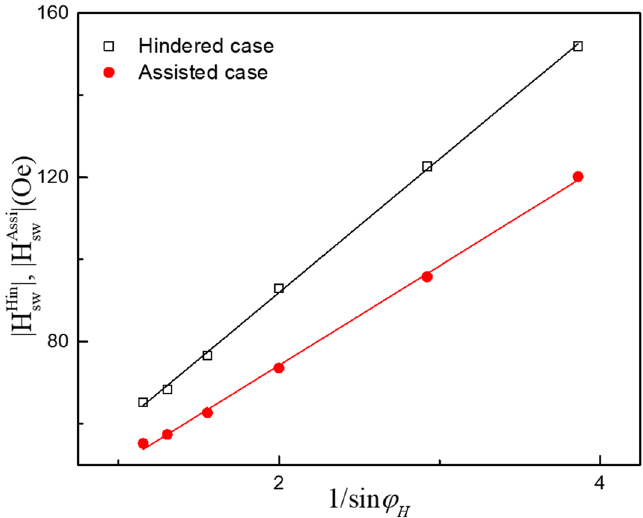
H Hin H Assi and observed for the GaMnAs SW SW (cid:31) (cid:31) (cid:31) (cid:31) (cid:31) (cid:31) (cid:31) (cid:31)